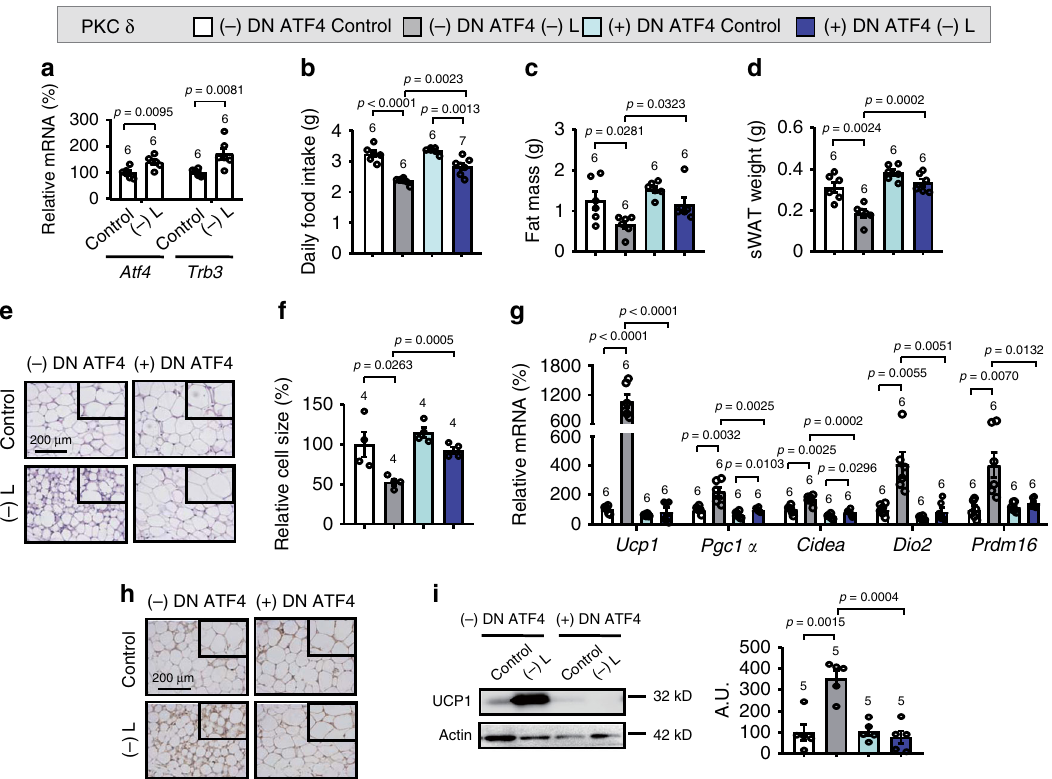
Fig. 5 Specially inhibition of ATF4 in amygdalar PKC- δ neurons blocks leucine deprivation-induced WAT browning. a Gene expression of Atf4 and Trb3 in amygdala by RT-PCR. b Daily food intake. c Fat mass by NMR. d Subcutaneous WAT (sWAT) weight. e Representative images of hematoxylin and eosin (H&E) staining of sWAT. f sWAT cell size quanti fi ed by Image J analysis of H&E images. g Gene expression of Ucp1, Pgc1a, Cidea, Dio2 , and Prdm16 in sWAT by RT-PCR. h Representative images of immunohistochemistry (IHC) of UCP1 in sWAT. i UCP1 protein in sWAT by western blotting (left) and quanti fi ed by densitometric analysis (right); A.U.: arbitrary units. Studies for a were conducted using 14- to 15-week-old male wild-type mice fed a control (Control) or leucine-de fi cient [(-) L] diet for 3 days; studies for ( b – i ) were conducted using 13- to 16-week-old male PKC- δ -Cre mice receiving AAVs expressing mCherry (PKC δ − DN ATF4) or DN ATF4 (PKC δ + DN ATF4) fed a Control or (-) L diet for 3 days. Data are expressed as the mean ± SEM ( n represents number of samples and are indicated above the bar graph), with individual data points. Data were analyzed by two-tailed unpaired Student ’